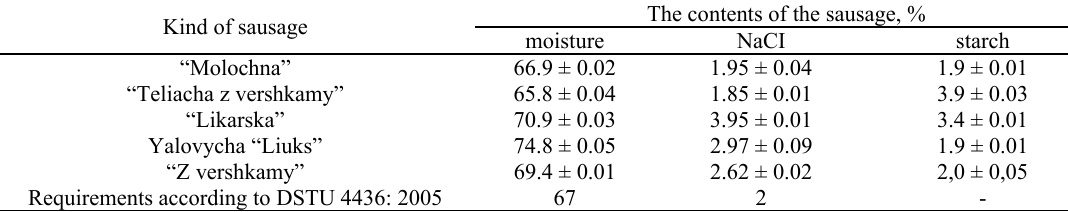
The contents of the sausage,